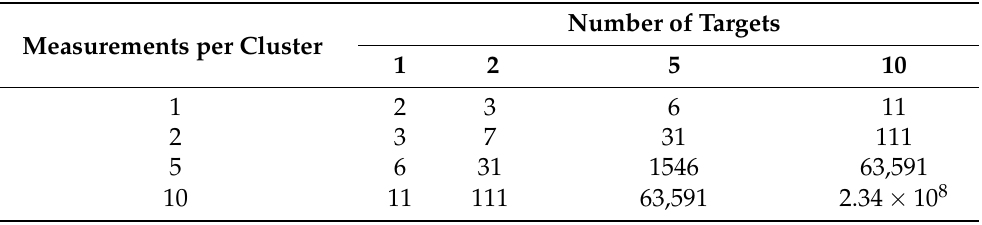
Table 1. Total Number of Feasibility Matrices for a Given Number of Targets per Cluster, adapted from Ref.